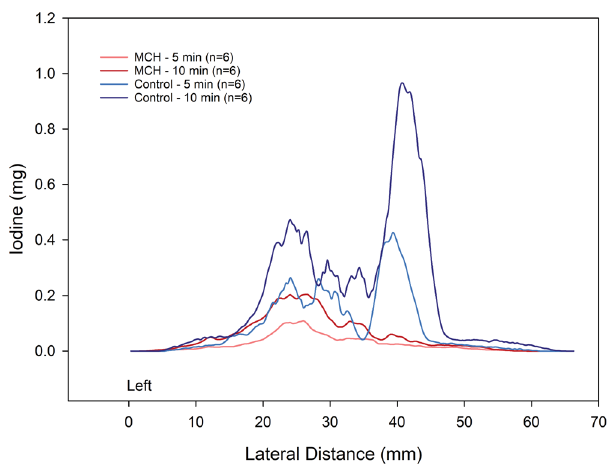
Figure 5. Comparison of regional iodine deposition in sample control and MCH – challenged animals, projected along the left-right axis, at 5 and 10 min of aerosol inhalation. Note the regional and inter-subject inhomogeneity of deposition, and the spatial similarity of deposition pattern between 5 and 10 min time